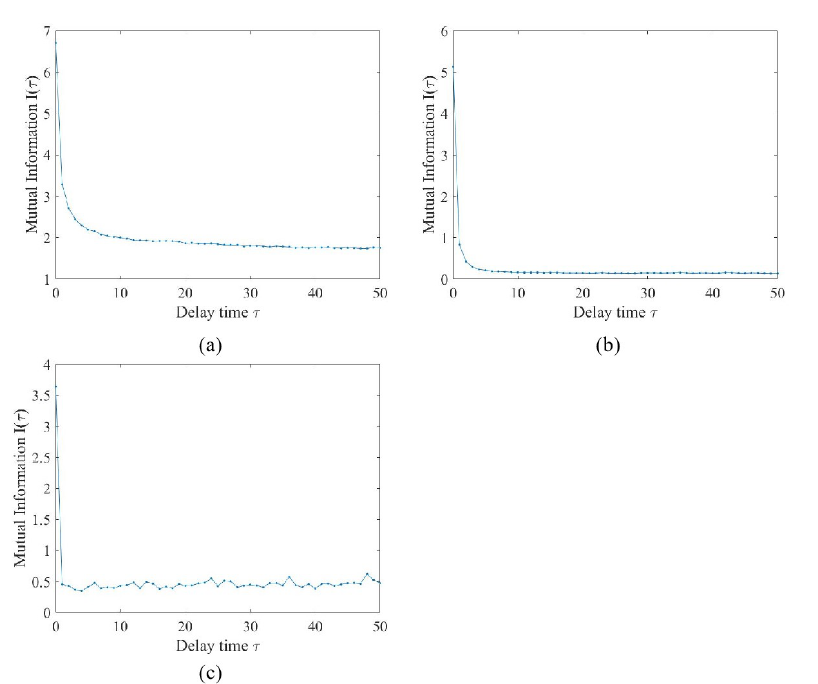
Figure 2. The mutual information of the EDH time series, where ( a – c ) are the hourly, daily, and monthly EDH time series, respectively.